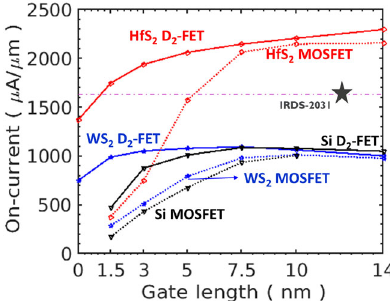
Fig. 15 Switching energy vs delay (EDP) of high-performance MOSFET and D 2 -FET inverters. EDP of 1ML-HfS 2 high-performance inverter cells, at various V DD (0.4 V to 0.7 V), made of L = 5 nm and L = 3 nm stacked DG MOSFETs (5 ribbons/device) and L = 0 nm and L = nm stacked SG-D 2 -FETs (nine ribbons/device). The EDP perfor- mance of Si HP inverter cells made of L = 12 nm stacked Si-GAA MOSFETs ( t S = 5 nm, 8 wires/device) and L = 5 nm stacked Si SG-D 2 - FETs ( t S = 3 nm, 7 ribbons/device) are also shown for